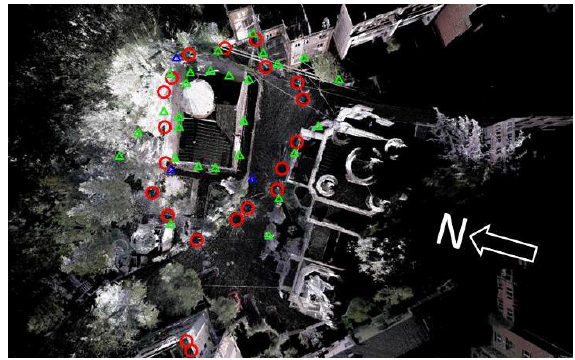
Figure 5. Overview of the registered BLK total point cloud with distribution of positions (red) and target marks (paper marks green, profit targets